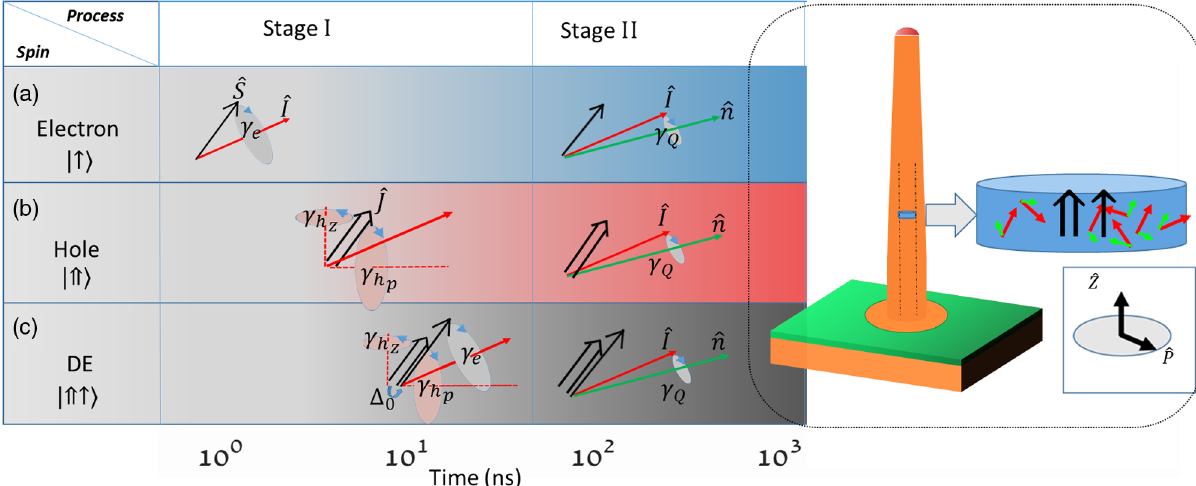
FIG. 2. Schematic description of the spin dephasing processes of the QD confined electron (a), heavy hole (b), and dark exciton (c). Each process is divided into two temporal stages: During the first stage the initiated central spin precesses around the effective magnetic ˆ S ) interacts field which results from the frozen fluctuation of the nuclear spins of about 10 5 atoms comprising the QD. The electron spin ( ˆ I ˆ J with the nuclear spin ( ) via the isotropic Fermi contact interaction described by γ . The heavy-hole spin ( ) interacts with the nuclear e and γ , where ˆ z is the QD growth direction and p denotes spin via the anisotropic dipole-dipole hyperfine interaction denoted by γ h z h p direction in a plane perpendicular to ˆ z . The dark exciton contains an electron and a heavy hole. Both spins interact with the nuclear spin, and in addition, the electron and hole interact with each other mainly via the isotropic exchange interaction denoted by Δ 0 [30]. During the second stage the nuclear spins react to strain-induced electric field gradients (EFG) in the QD [31]. This interaction has a quadrupole nature, and we denote it by γ . The motion of each nuclear spin is described by an effective local magnetic field in a direction marked by Q ˆ n which the nuclear spin slowly precesses around. During the second stage, we use the adiabatic approximation, by which the central spin just follows the slowly varying effective nuclear magnetic field. The various interaction magnitudes are summarized and referenced in Table I. Inset: schematic description of the InAsP QD (blue) embedded in the InP photonic nanowire (orange). The central spin is represented by the black arrows, the nuclear spin bath are represented by the red arrows, and the EFGs are schematically represented by green arrows in the magnified description of the